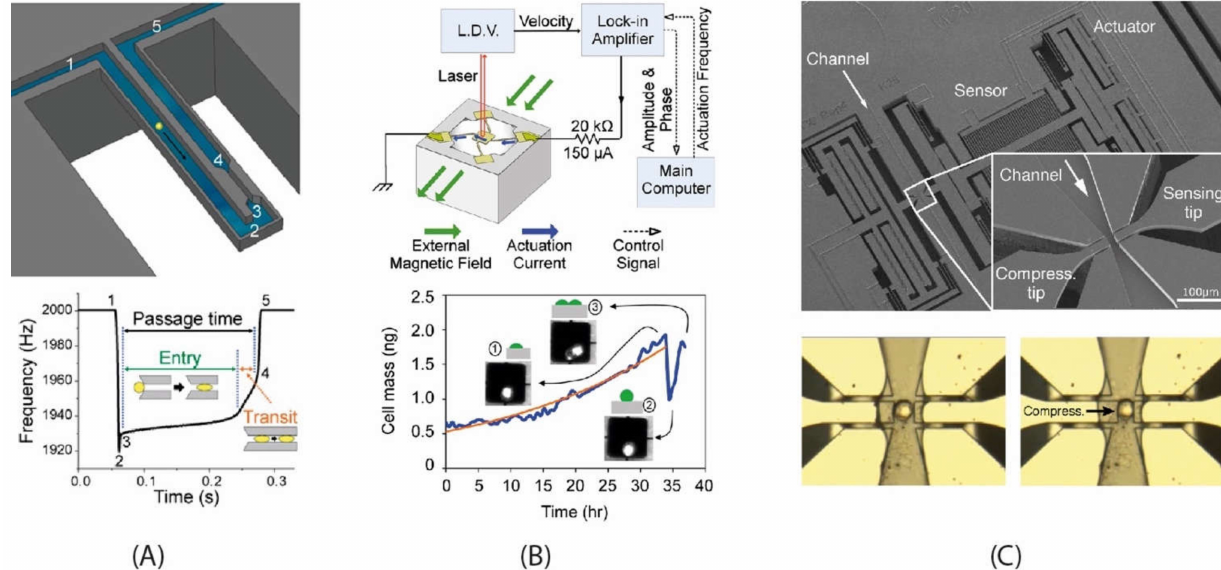
Figure 3. Examples of silicon-based resonating MEMS technologies for analysing cells. ( A ) The cantilever-type suspended channel device coupled a constriction located at the apex of the channel, described by Byun et al. [35] (with granted permission from PNAS). The cell (represented as the yellow sphere) is deformed by the 6 µ m-wide, 15 µ m-deep, and 50 µ m-long constriction. The numbers 1 to 5 indicate the trajectory of the cell. The resonant frequency change of the cantilever structure changes with the cell passing in the channel and going through the constriction. ( B ) Suspended plate resonant sensor described by Park et al. [12] (with granted permission from PNAS), where the cells are cultured on a sensor platform and the increase in mass through cellular growth is measured. The graph on the right monitors a cell division event. Prior to cell division, an individual cell’s growth data (blue line) conforms to an exponential curve fitting. Insets 1–3 show the cell division event. ( C ) The fluidics-integrated MEMS squeezer device, described by Takayama et al. [65], has only the tips of the device enter the microchannel while the sensing and measurement components are not submerged, allowing simultaneous electrical and mechanical measurements in air (CC BY license). Table 3. An overview of the targeted cellular biological samples. The device type column corresponds to the order of the devices introduced in Section 3.1 and Table